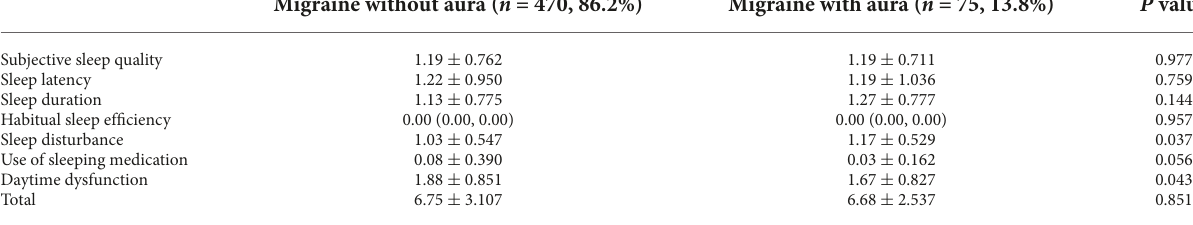
TABLE 2 Total and sub-item PSQI scores among participants with Migraine with/without aura.